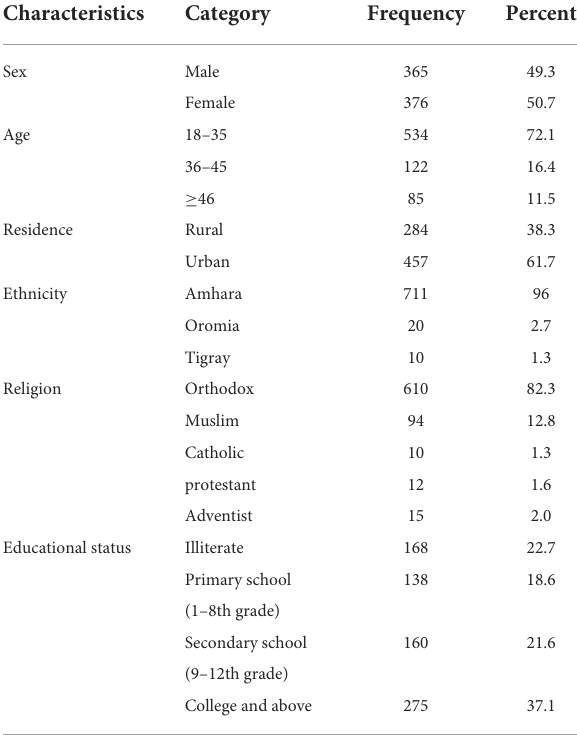
TABLE 1 Sociodemographic characteristics of the community living in south Gondar zone, Amhara, Ethiopia 2021 ( n = 741).